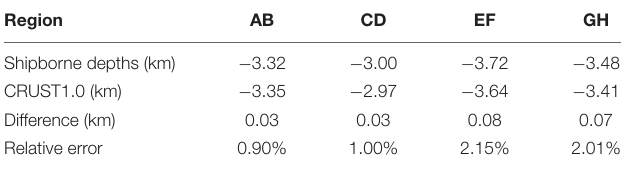
TABLE 8 | Mean water depth